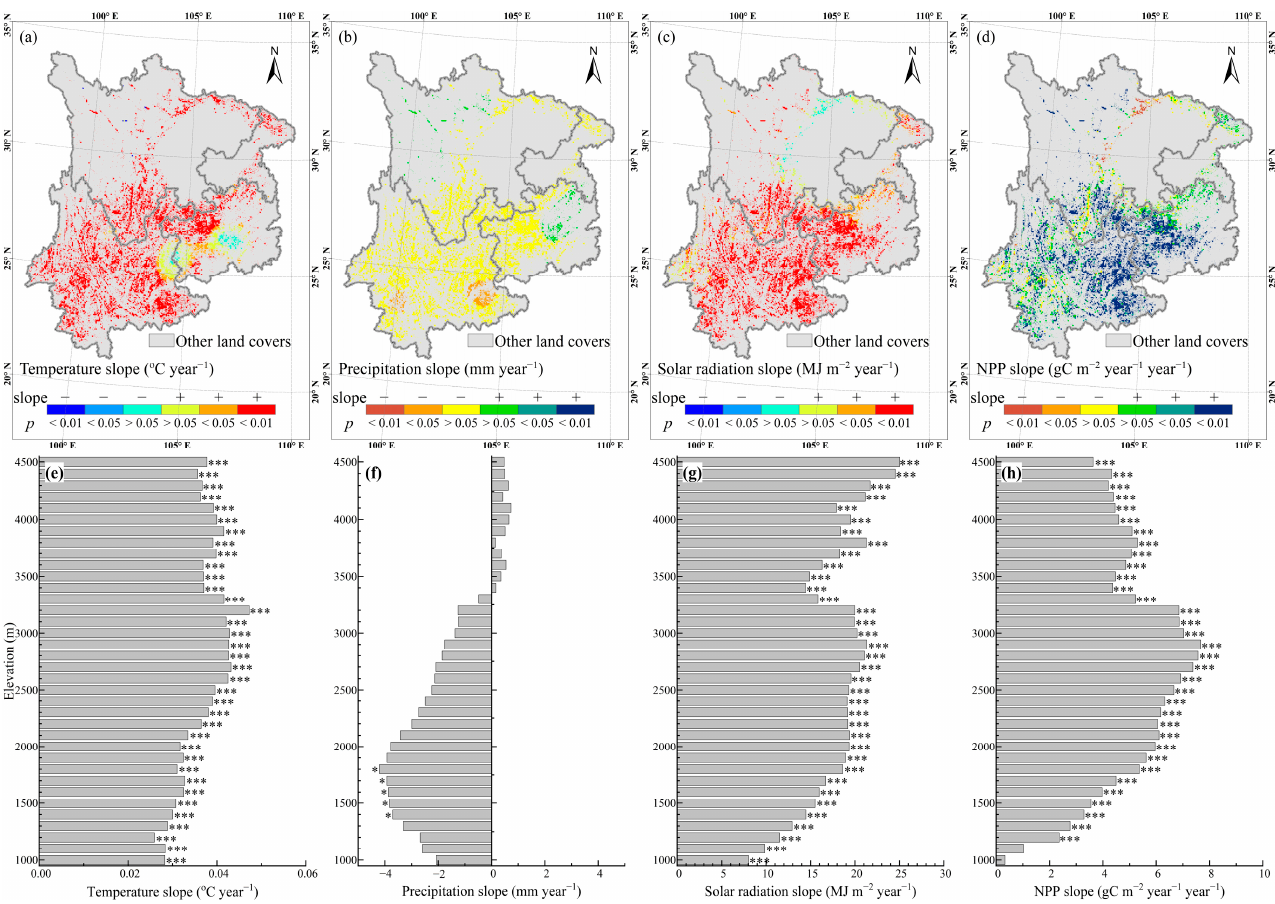
Figure 5. Spatial patterns and elevational gradients of interannual change trends in cropland ecosystem NPP, temperature, precipitation, and solar radiation, respectively. Subfigure ( a – d ) show spatial patterns of interannual change trends in temperature, precipitation, solar radiation, and NPP respectively, while subfigure ( e – h ) show elevational gradients of interannual change trends in temperature, precipitation, solar radiation, and NPP respectively. One asterisk next to column bar means the correlation reached a statistically significant level ( p < 0.05). Three asterisks next to column bar refer to a p ‐ value of the correlation of less than 0.001.